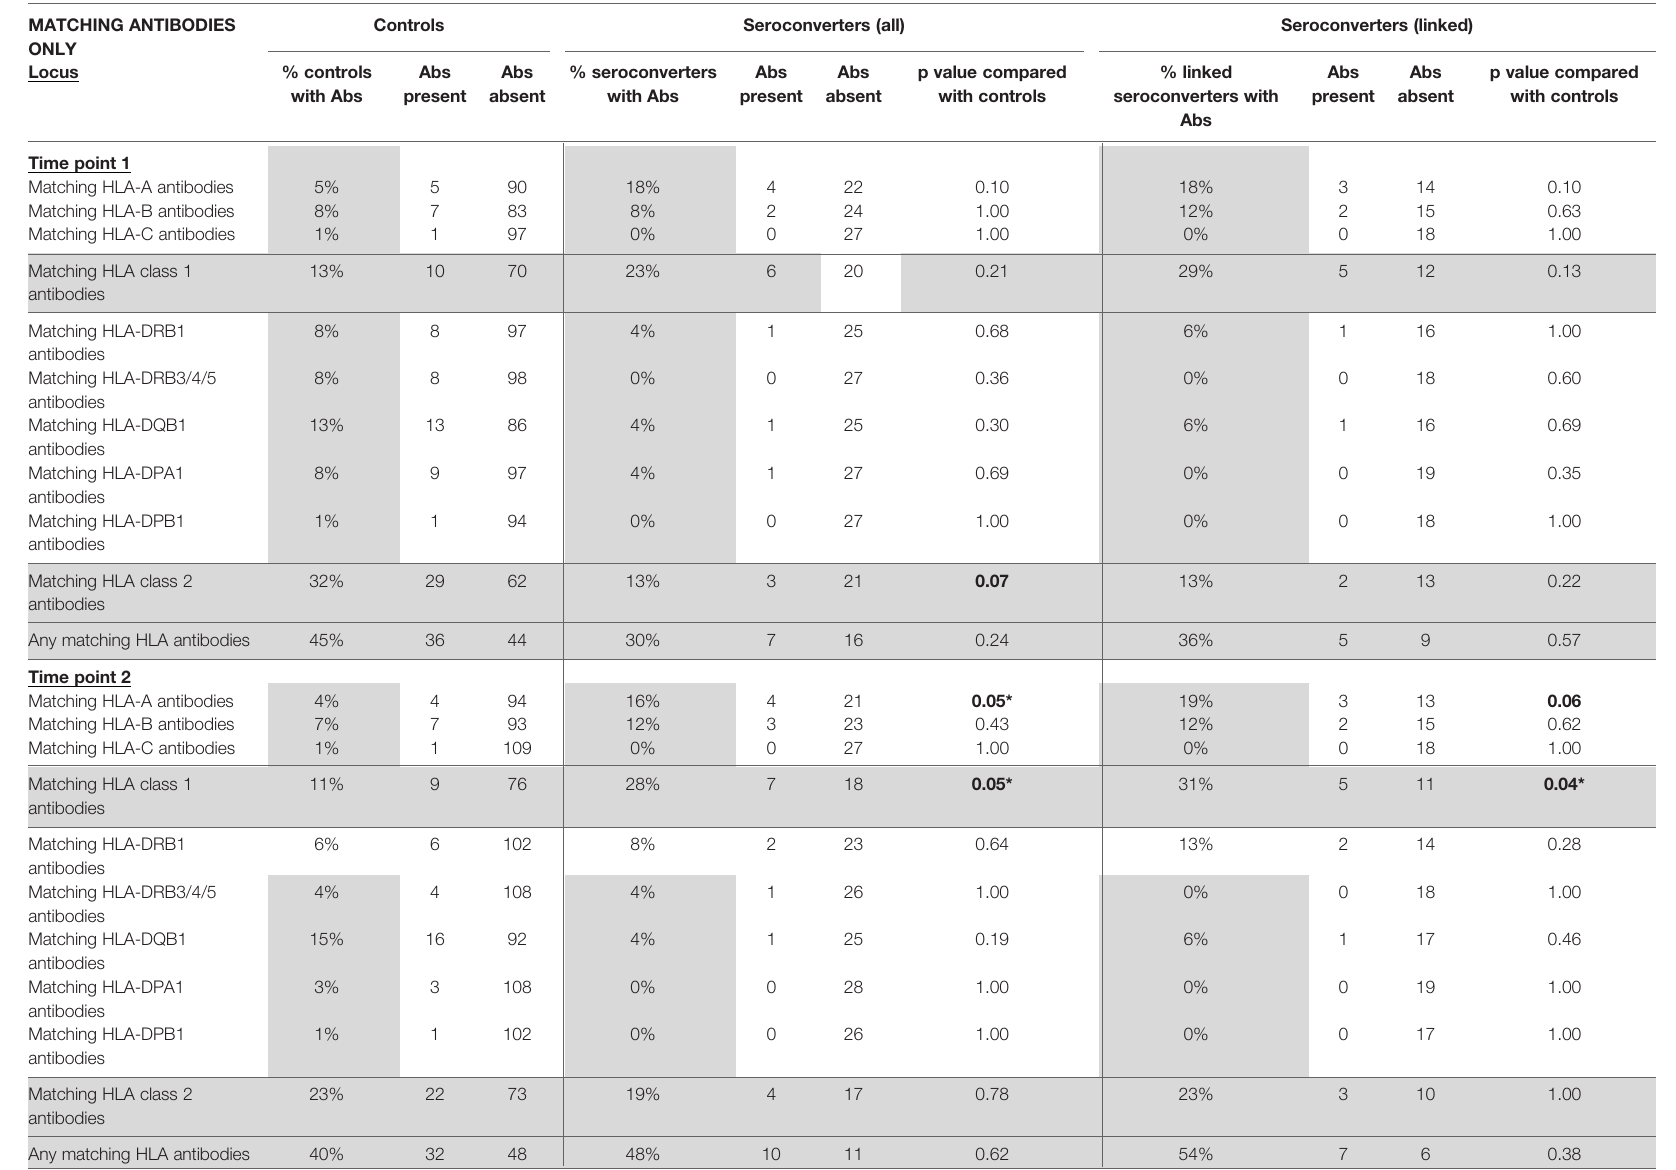
The proportion of highly exposed persistently seronegative controls, HIV-seroconverters and linked HIV-seroconverters with matching antibodies against the index partner genotype at each speci fi c locus are indicated as percentages. The number of positive and negative individuals analyzed at each locus are also shown. p values were calculated using Fisher ’ s exact test and apply to within-row comparisons; Abs, Antibodies; bold fi gures indicate trend to signi fi cance p<0.01; asterisk indicates signi fi cant p values<0.05. Vertical numbers are not cumulative as one individual may express antibodies to more than one HLA locus, and number of analyzable results differed per